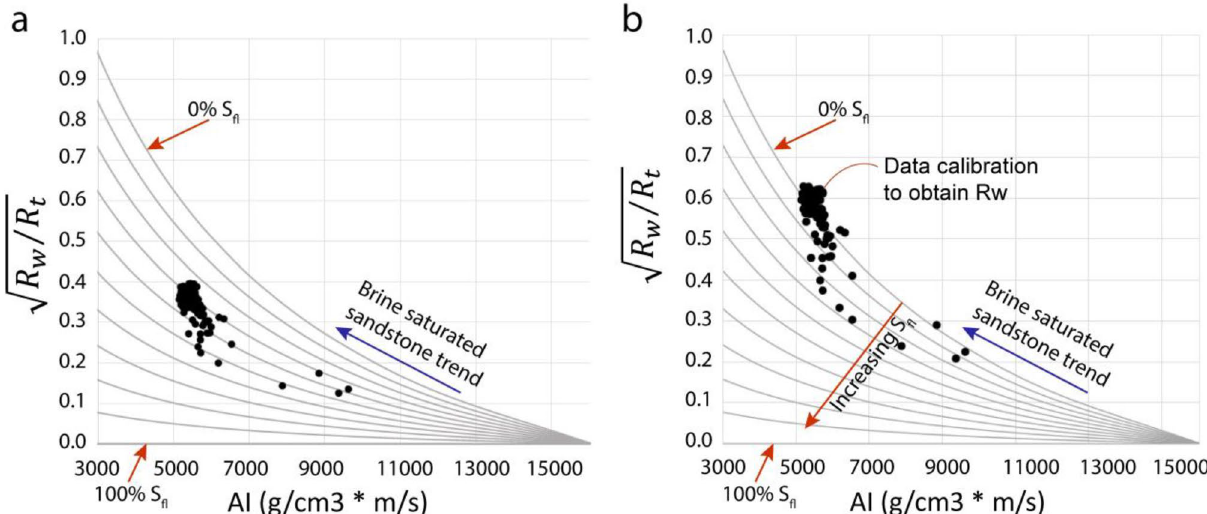
Figure 7. Method of finding R w by calibrating the brine sandstone/siltstone trend in the data with the reference 0% fluid saturation (S fl ) line onto the Acoustic impedance-resistivity ratio function ( √ R w / R t ) plane. ( a ) Data before calibration, ( b ) data after R w iteration and adjustment, so the brine saturated sandstone trend is calibrated with the 0% S fl